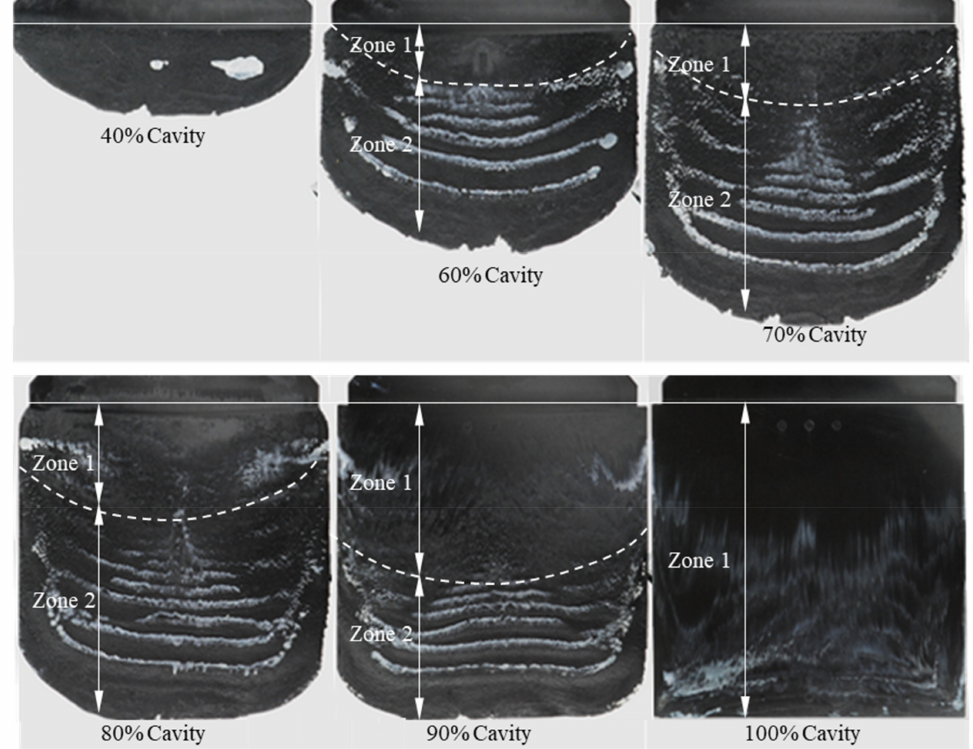
Figure 6. Mechanism of slip phenomenon. Material is PF1110 (GF35+GB45). Mold temperature is 175 ◦ C, and injection speed is 16 cm 3